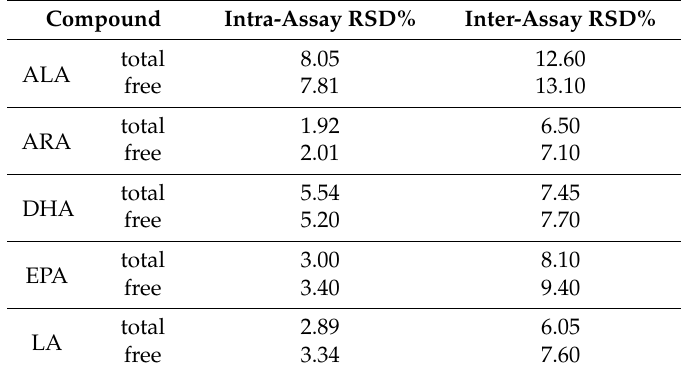
Table 4. The results for replicated analysis of samples (test precision). The sample was analysed 10 times in the same day (within-run precision) and 5 times in different days (between-run precision). The obtained concentrations were used to calculate the relative standard deviation